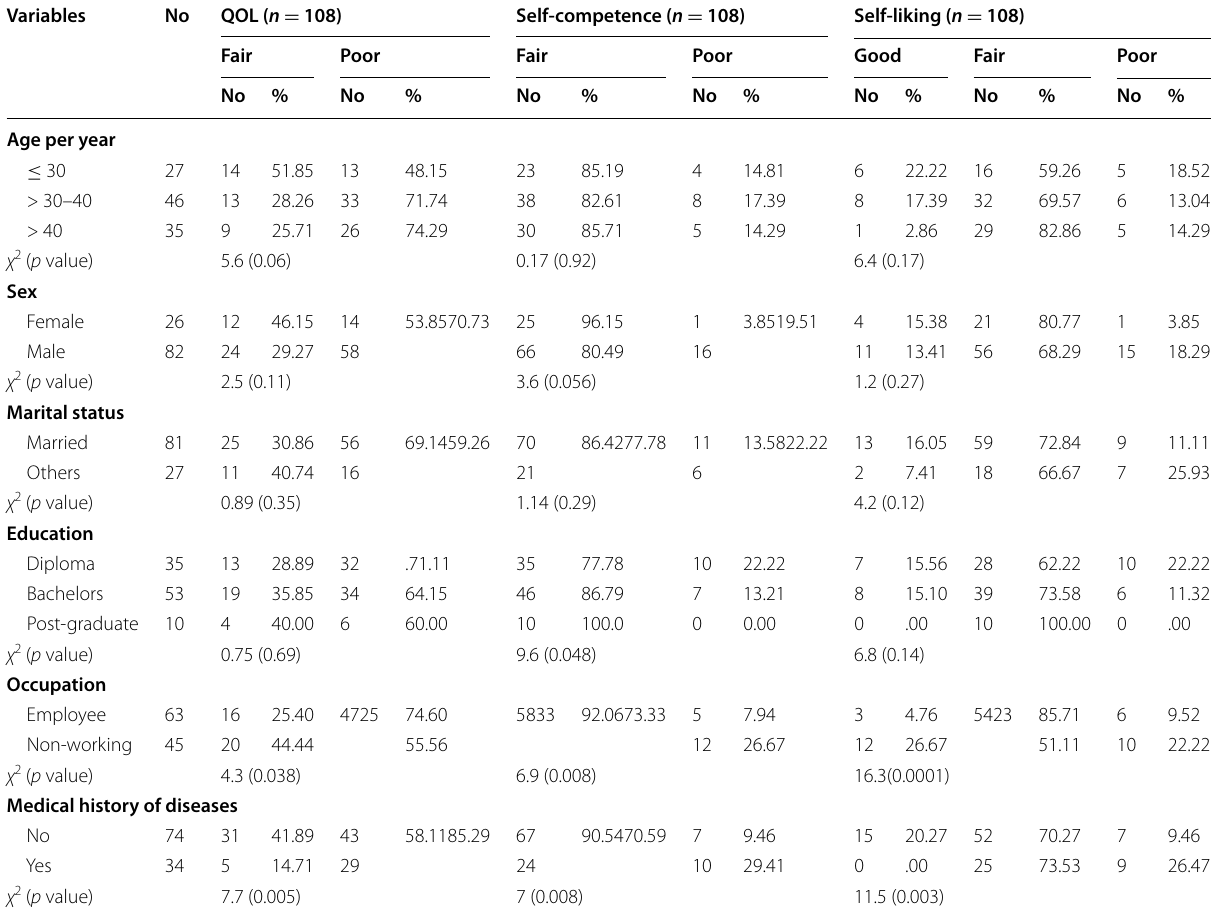
Table 5 Relation between QOL, self‑competence, and self‑liking of caregivers of ADHD children and their socio‑demographic